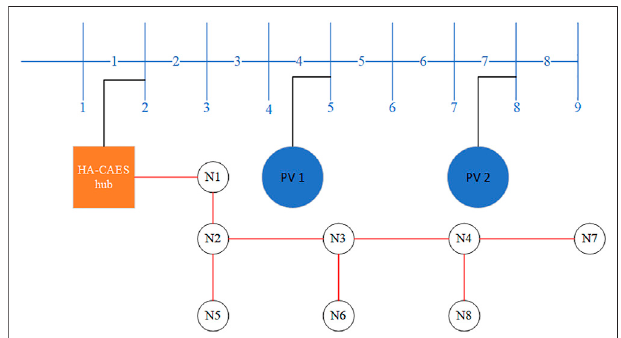
FIGURE 4 | Con fi guration of the